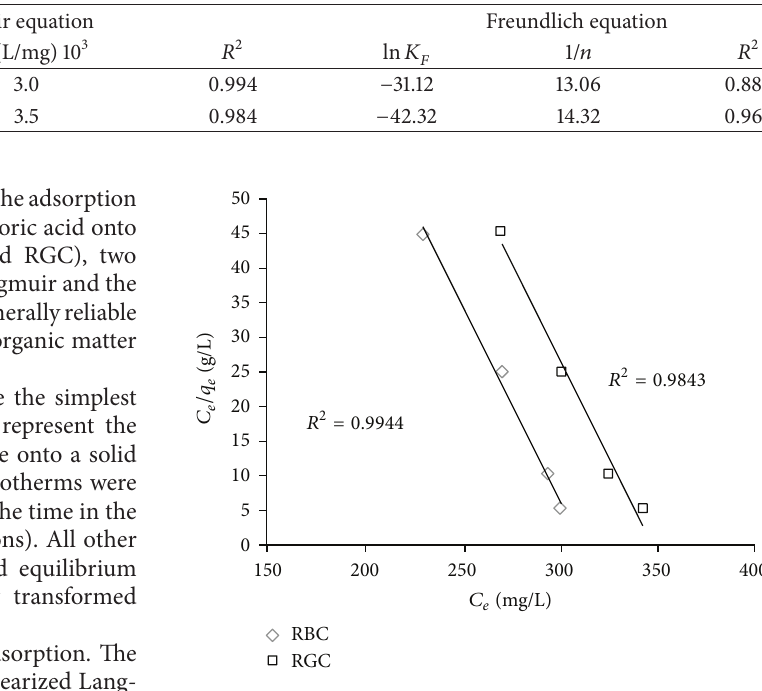
Figure 7: Langmuir equilibrium isotherms of OM adsorbed onto RBC and